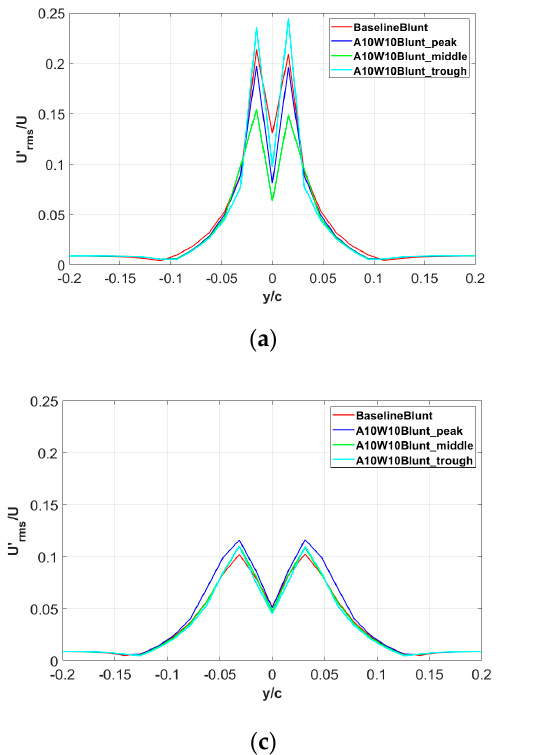
Figure 17. Distribution of the mean streamwise velocity in the wake region: ( a ) x = 1.1 c ; ( b ) x = 1.2 c ; ( c ) x = 1.3 c . ( c ) x = 1.3 c .